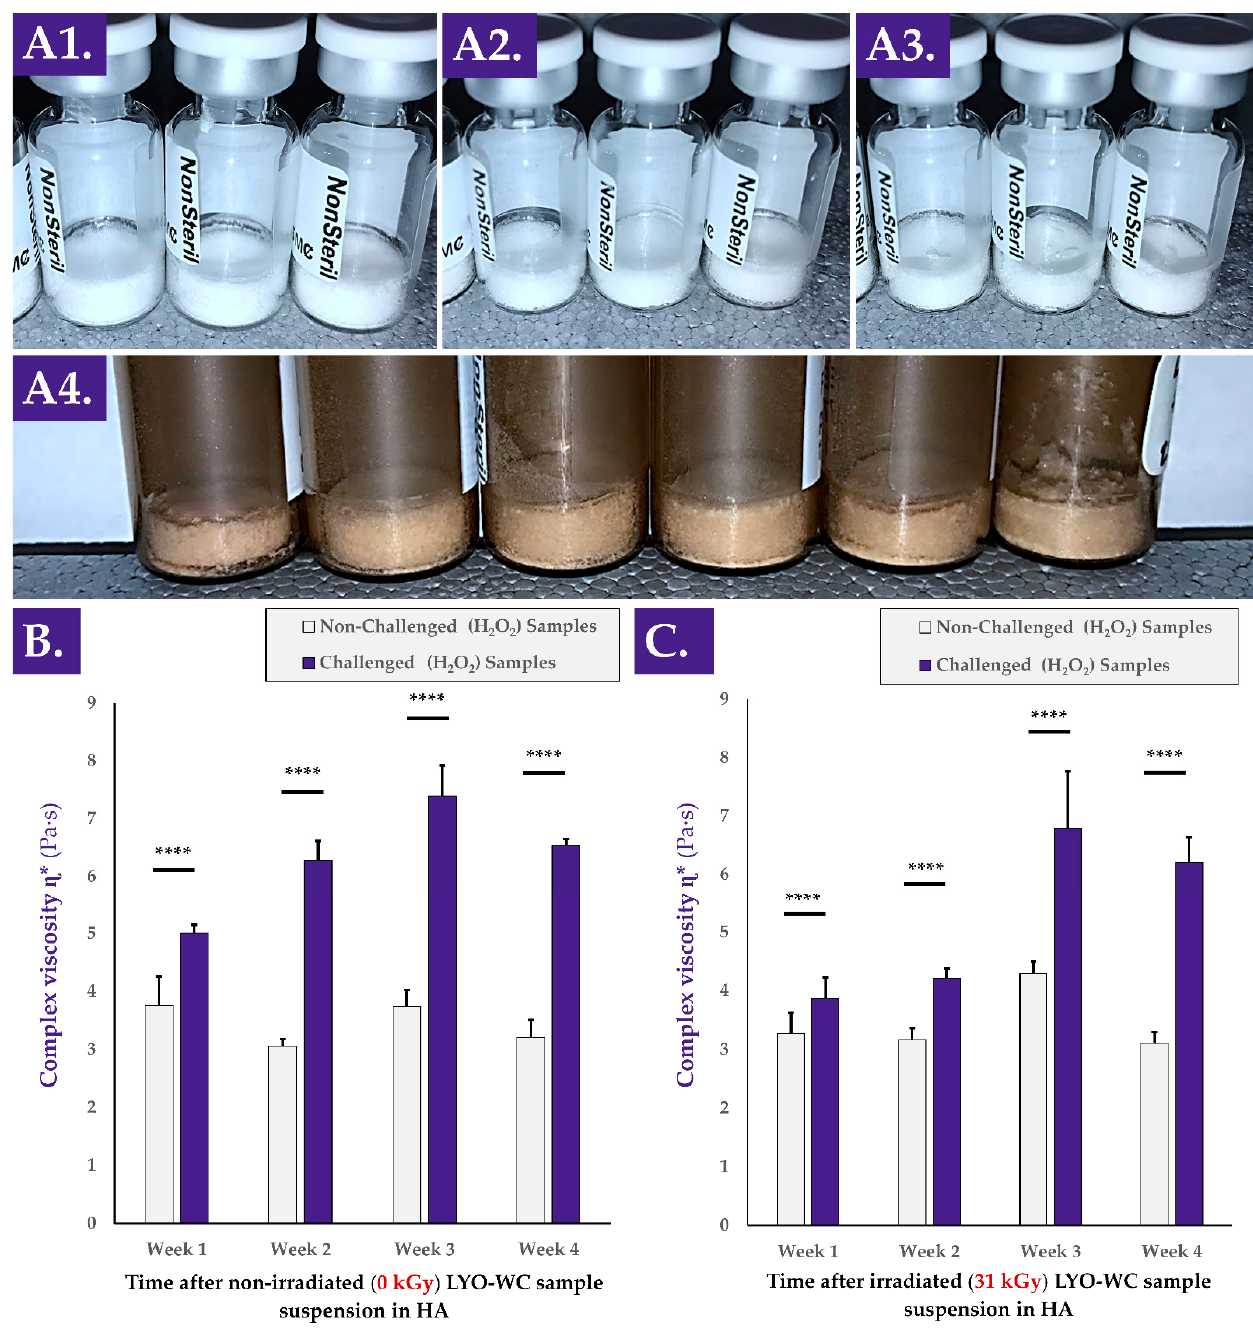
Figure 4. Photographic records of whole-cell lyophilizates after three months of storage at 4 °C ( A1 ), after three months of storage at 37 °C and 90% relative humidity ( A2 ), after three months of storage at − 80 °C and 48 h at ambient temperature ( A3 ), and after γ -irradiation at 50 kGy ( A4 ). Complex viscosity η * value evolution at various timepoints after non-irradiated ( B ) and γ -irradiated (31 kGy, ( C )) whole-cell lyophilizate reconstitution in HA-based hydrogels (2.2–2.4 MDa MW) within an oxidative challenge assay. Extremely significant (i.e., **** or p value < 0.0001) differences were found between each challenged sample and the corresponding unchallenged control. HA, hyaluronic acid; kGy, kiloGray; LYO-WC, lyophilized whole-cell fraction; MDa, megadalton; MW, molecular weight; Pa · s, Pascal